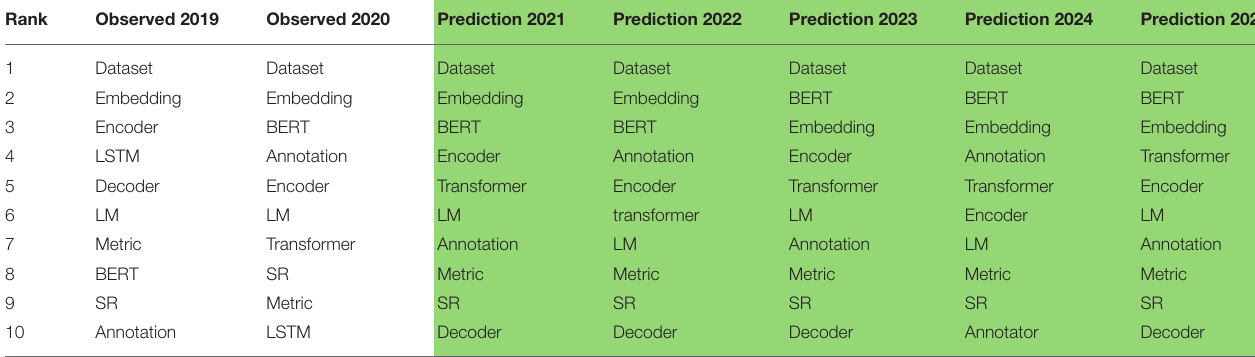
Predictions are marked in